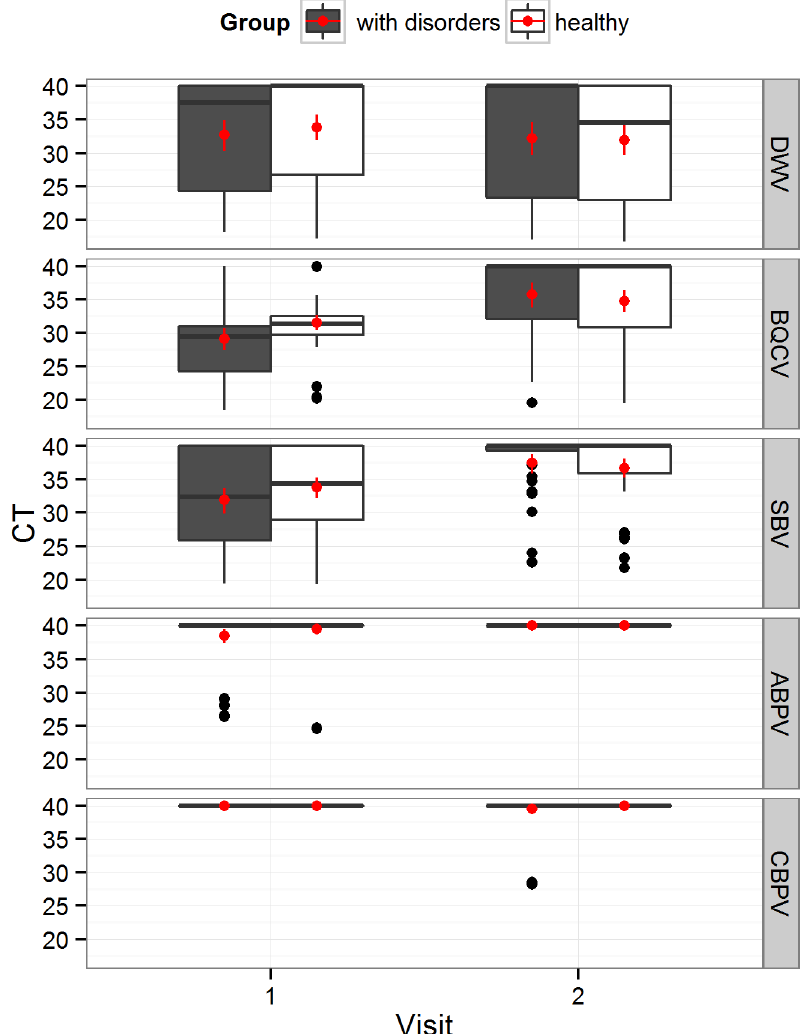
Figure 2. Virus content according to the Cycle Threshold (CT) for the groups ‘‘with disorder’’ and ‘‘healthy’’. Boxplot of Cycle Threshold for the first and second visits (visit 1 - mid-July to mid-august and visit 2 - mid-September to mid-October) and the group with disorders (grey, n=24 colonies) and the healthy one (white, n=29 colonies). Deformed Wings Virus (DWV), Black Queen Cell Virus (BQCV), SacBrood Virus (SBV), Acute Bee Paralysis Virus (ABPV), Chronic Bee Paralysis Virus (CBPV). In red, mean with confidence interval estimated by boostrap method. Note: CT values below 40 were regarded as positive results and the lowest CT values correspond to the higher virus contents. doi:10.1371/journal.pone.0103073.g002 PLOS ONE |